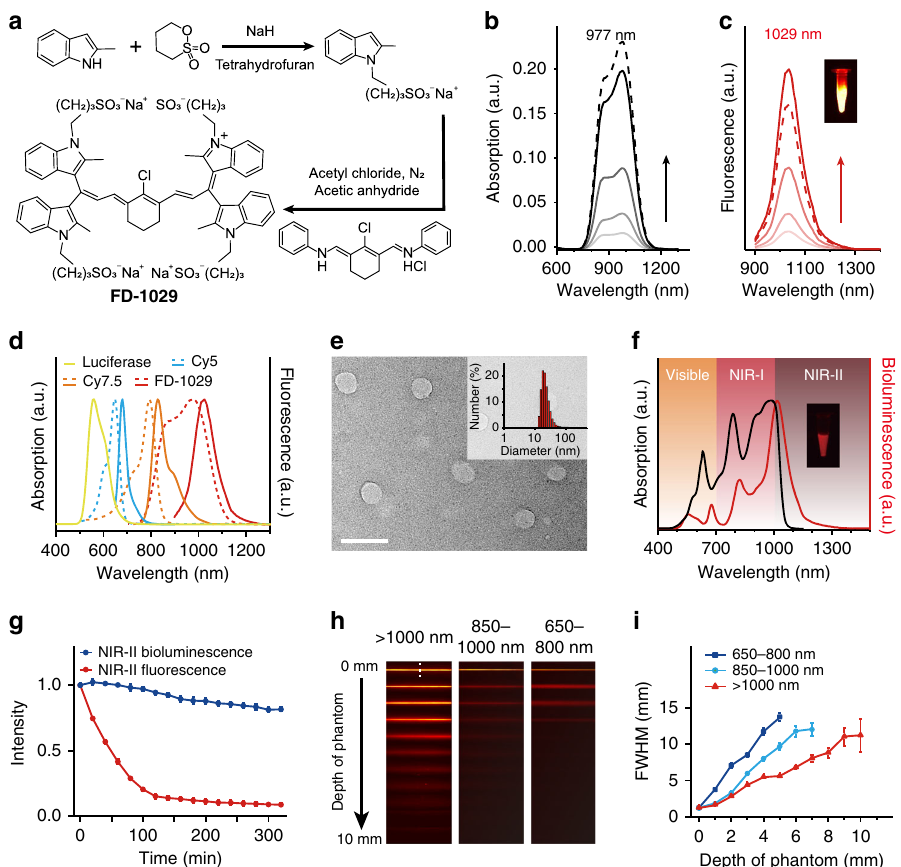
Fig. 2 Synthesis and characterization of NIR-II-BPs. a Synthetic route of FD-1029. b Absorbance spectra of FD-1029 in DSPE-PEG2000 micelles with the concentration of 1, 2, 5, 10 μ M (from bottom to top). The dashed line refers to 12 μ M FD-1029 in micelles. c Fluorescent emission spectra of FD-1029 in DSPE-PEG2000 micelles with the concentration of 1, 2, 5, 10 μ M (from bottom to top). Inset: NIR-II fl uorescence image of FD-1029 in DSPE-PEG2000 micelles (10 μ M) (1000 nm long-pass fi lter) under excitation of 980 nm. d UV/VIS/NIR absorption and emission spectra of Cy5, Cy7.5, FD-1029, and bioluminescence of luciferase. Dashed and solid lines refer to absorption and emission spectra, respectively. e Representative TEM image and size distribution of NIR-II-BPs in PBS buffer. Scale bar, 50 nm. Repeated for three times in independent experiments. f Bioluminescence emission spectrum and absorption spectrum of NIR-II-BPs in PBS buffer. g Photostability of NIR-II-BPs in mouse serum. Bars represent mean ± s.d. derived from n = 3 independent detections. h Bioluminescence images of capillaries fi lled with NIR-II-BPs immersed with 1% intralipid at varied depth in different detection windows. i The FWHM of Gaussian fi tted intensity data in g versus different intralipid depth. Bars represent mean ± s.d. derived from n = 3 independent experiments. Source data underlying g and i are provided as a Source Data fi